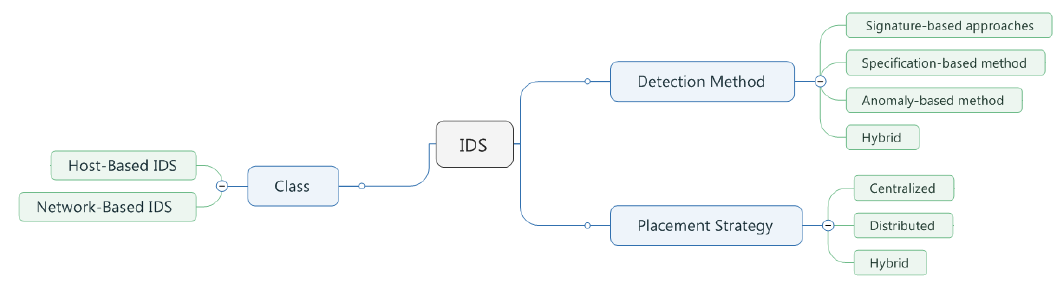
Figure 1. Types and placement of intrusion detection systems (IDS).